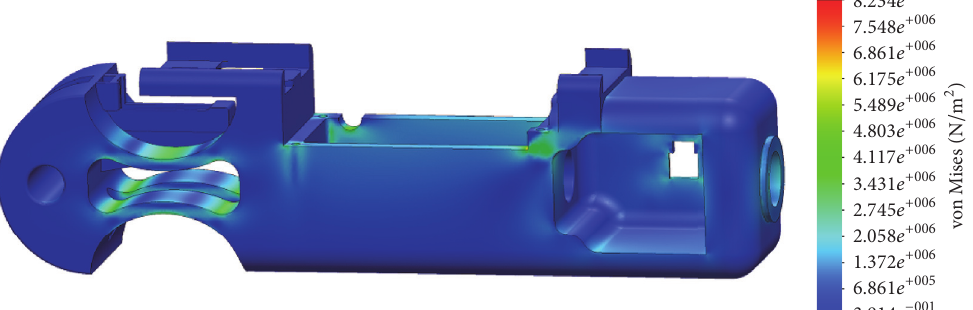
Figure 7: Finite Element Analysis of the compliant frame.